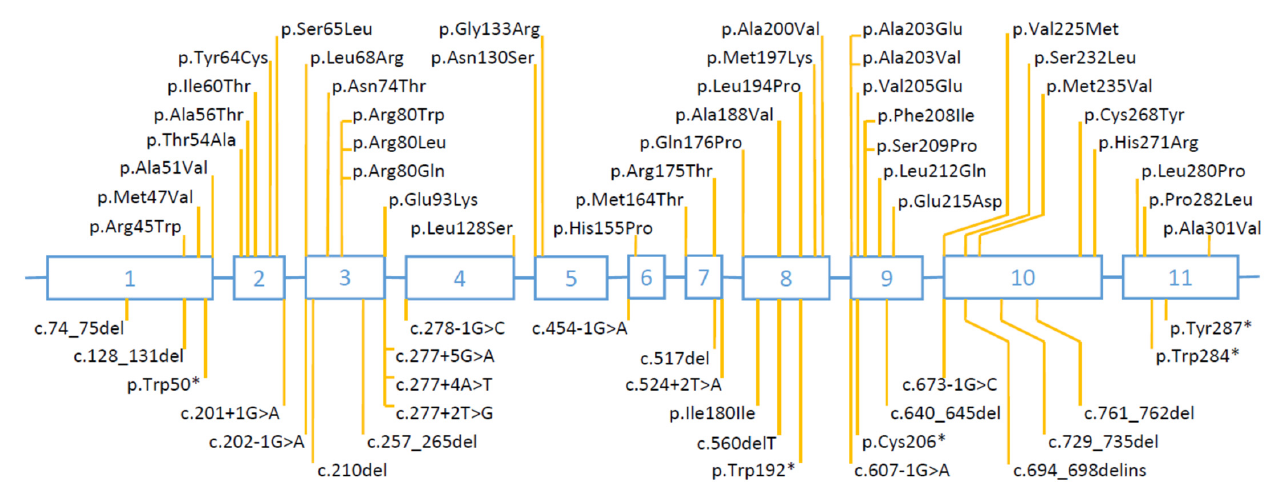
Figure 2. Location of mutations reported in the literature. Open boxes (numbered 1 to 11) represent coding exons of the 17-beta-hydroxysteroid dehydrogenase 3 ( HSD17B3 ) gene and intervening horizontal lines represent introns (not drawn to scale). Missense mutations are depicted above the gene structure and all other mutations are represented below. Gross rearrangements (whole exon deletions and duplications) are not represented. Please refer to Supplemental Table S1 for further details.